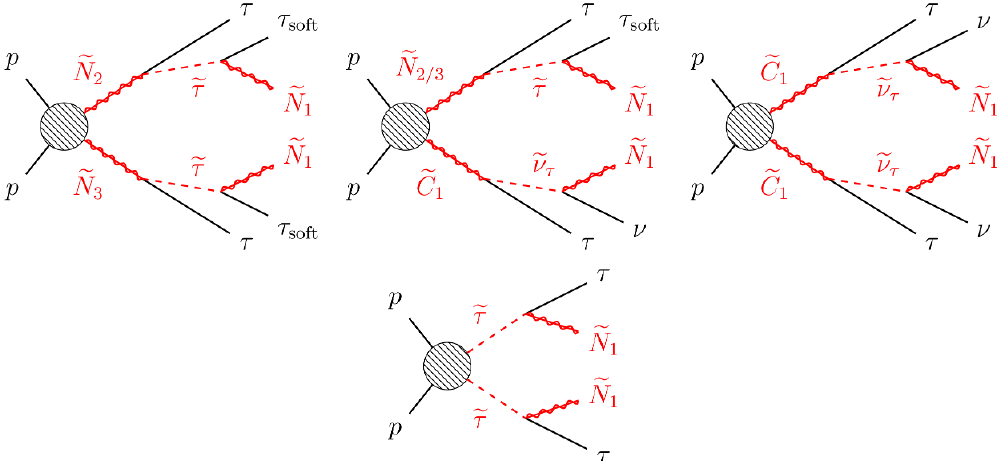
Figure 3 . Top: the Feynman diagrams of the neutralino/chargino production that produce two hard taus in the present scenarios, corresponding to the processes (3.6), (3.7), and (3.8). Bottom: direct production of staus decaying into taus and LSPs, which is the original target of the ATLAS search we recast [37]. In our scenarios, this process will not yield signal events because the taus from this process are